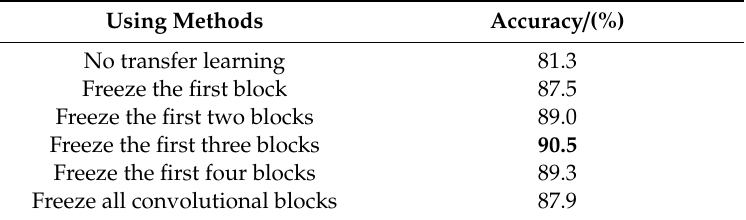
Table 1. Experiment results of di ff erent use of transfer learning on self-built